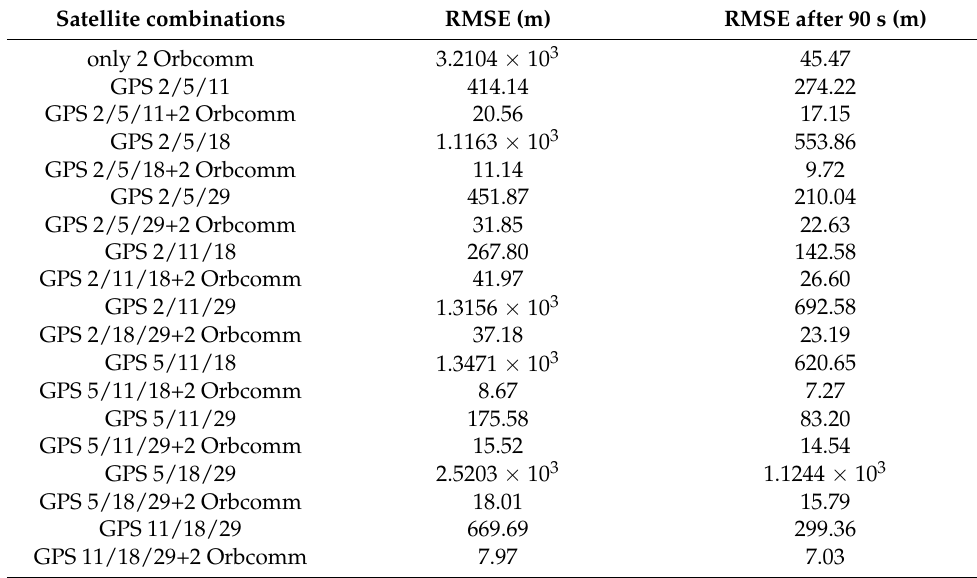
Table 3. RMSE of the baseline error under epoch accumulation of HB-DLG algorithms. Satellite combinations RMSE (m) RMSE after 90 s